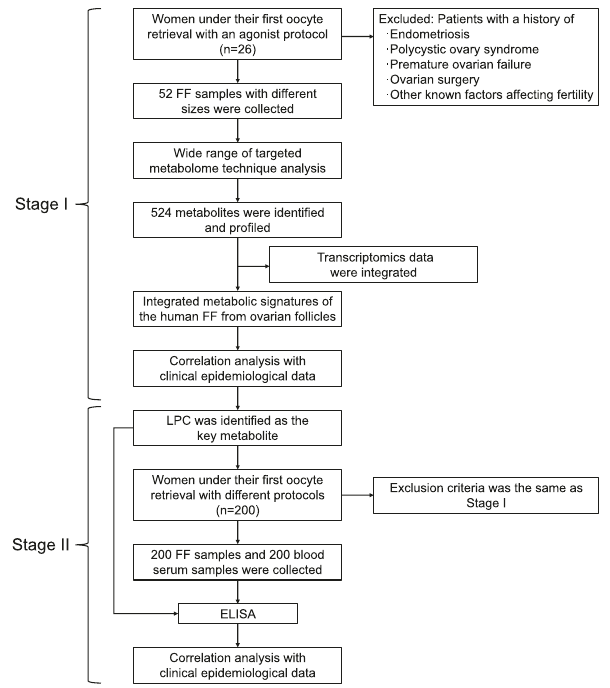
Fig. 7 The two-stage study design of this study. This was a two-stage experiment involving 452 samples from 226